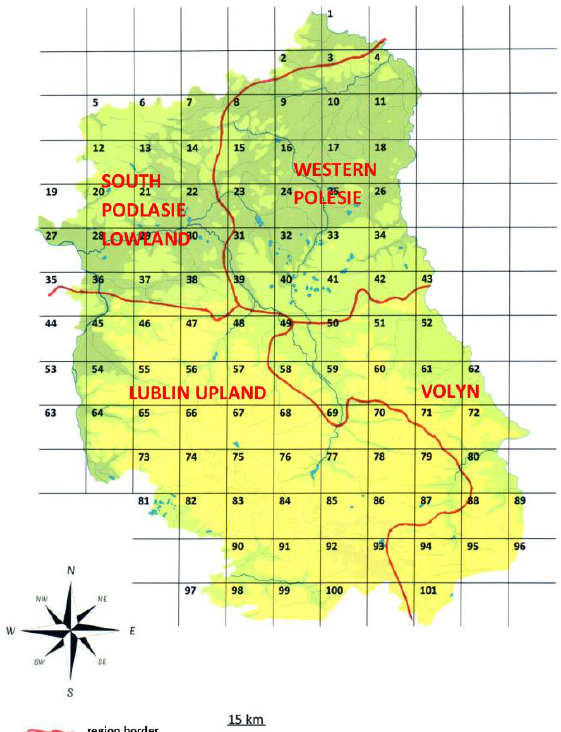
Figure 2. Division of Lublin Province into study plots and physico-geographical regions of Lublin